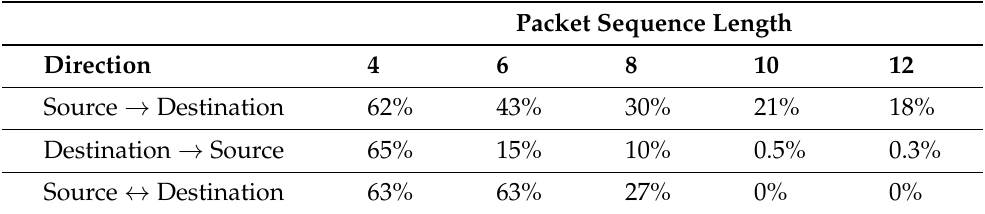
Table 9. Resulting false discovery rate (FDR) of different types of signatures against part of the benign traffic. Signatures are part of the attack samples from the “DoS” category. The signatures are generated after a combination of packet direction and packet payload